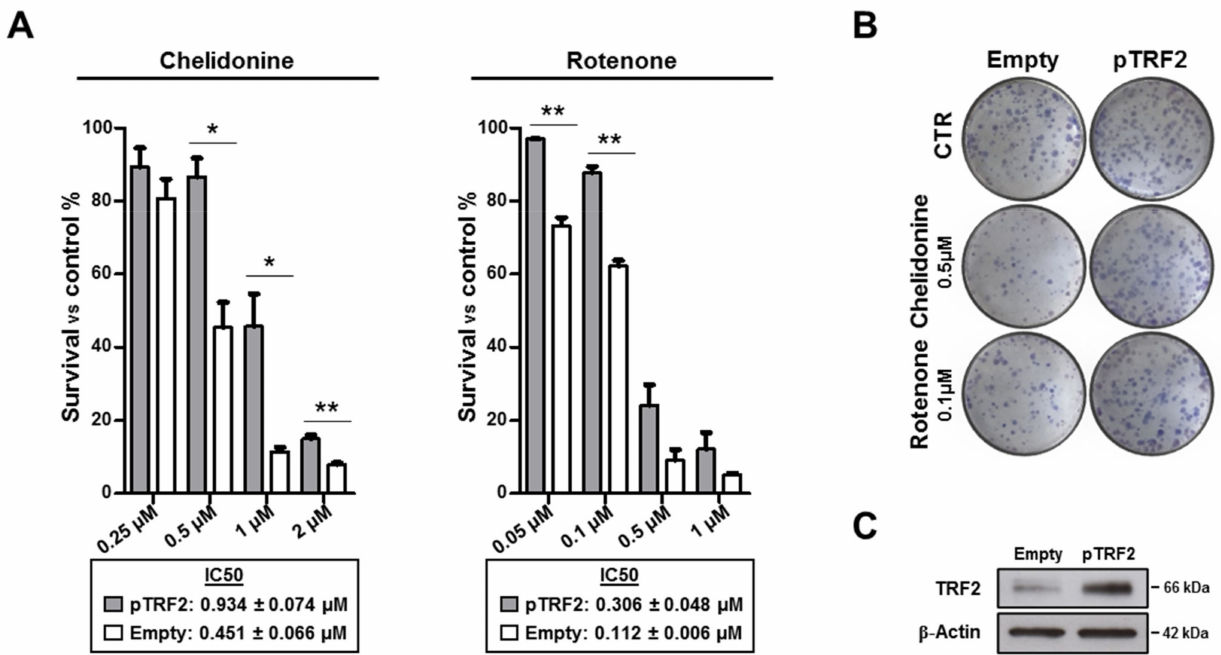
Figure 8. TRF2 over-expression protects cells from effect of Chelidonine and Rotenone. Clonogenic assay on MDA-MB-231 stably over-expressing TRF2. ( A ) Dose-dependent colony formation decrease upon Chelidonine and Rotenone treatment. ( B ) Representative images of colony survival. ( C ) Representative Western blot of TRF2 over-expression. ns, p > 0.05; *, p < 0.05; **, p <